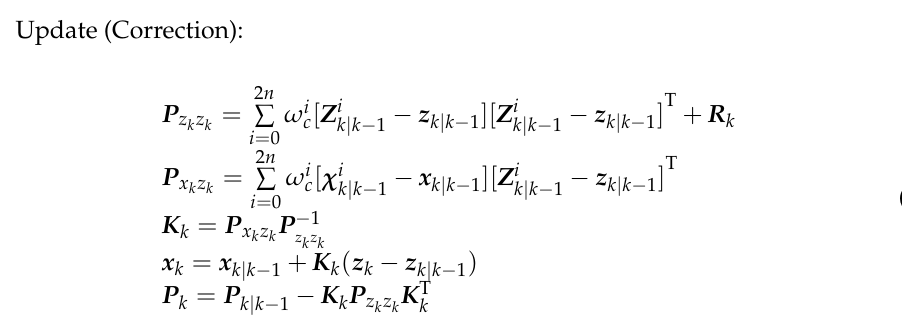
Figure 11. Comparison of relative velocity parameters.